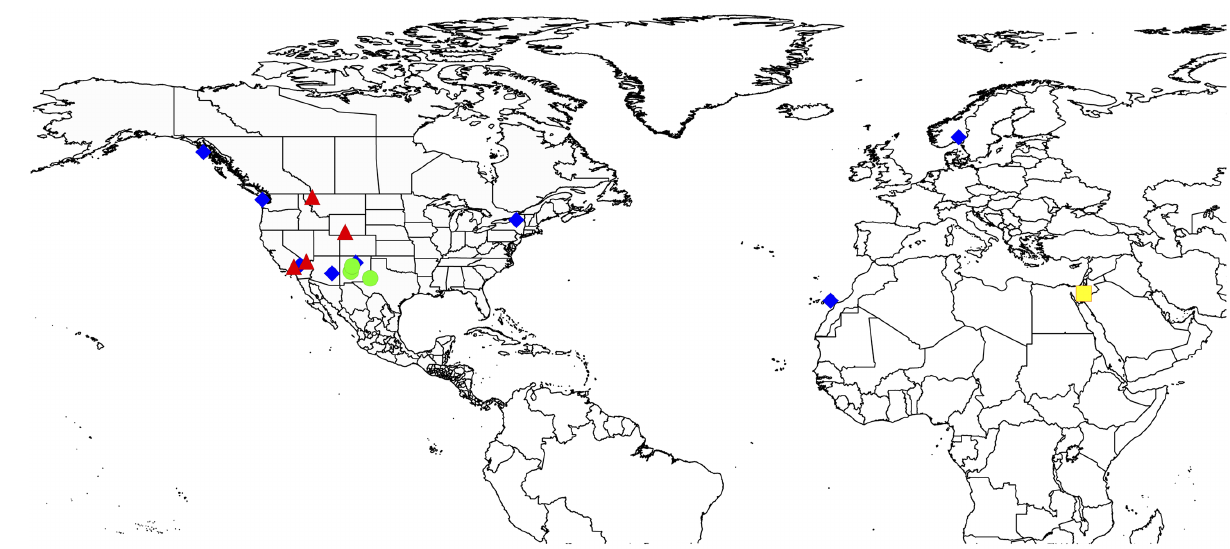
Fig 1. Map showing sampling locations. Blue diamond= C . corax , Holarcticlineage;red triangle= C . corax , Californialineage;green circle = C . cryptoleucus ; yellow square = C . ruficollis .